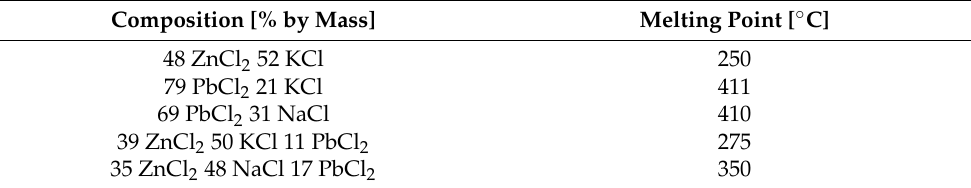
Table 1. Eutectics—melting point.